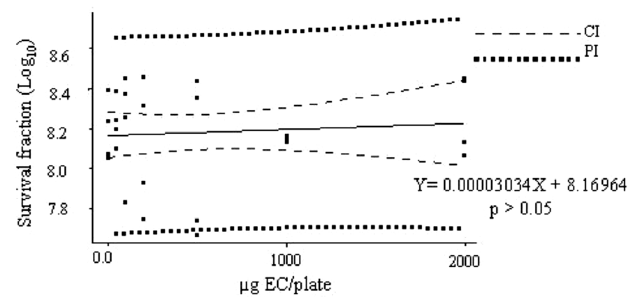
FIGURE 2 - Number of plaques as a function of the concentration of Curatella americana ethanolic extract. E. coli WP2s(λ) cultures during the exponential phase of growth were centrifuged, resuspended, incubated for 25 min with different concentrations of Curatella americana stem bark ethanolic extract, diluted with M9 buffer, inoculated into LB plates, together with 0.3 mL (1/2)(mal/amp) of the indicator culture RJF013, and 2.5 mL of top agar, incubated for 24 h at 37 °C, after what the plates were counted. . CI: 95% confidence interval; PI: 95% predicted